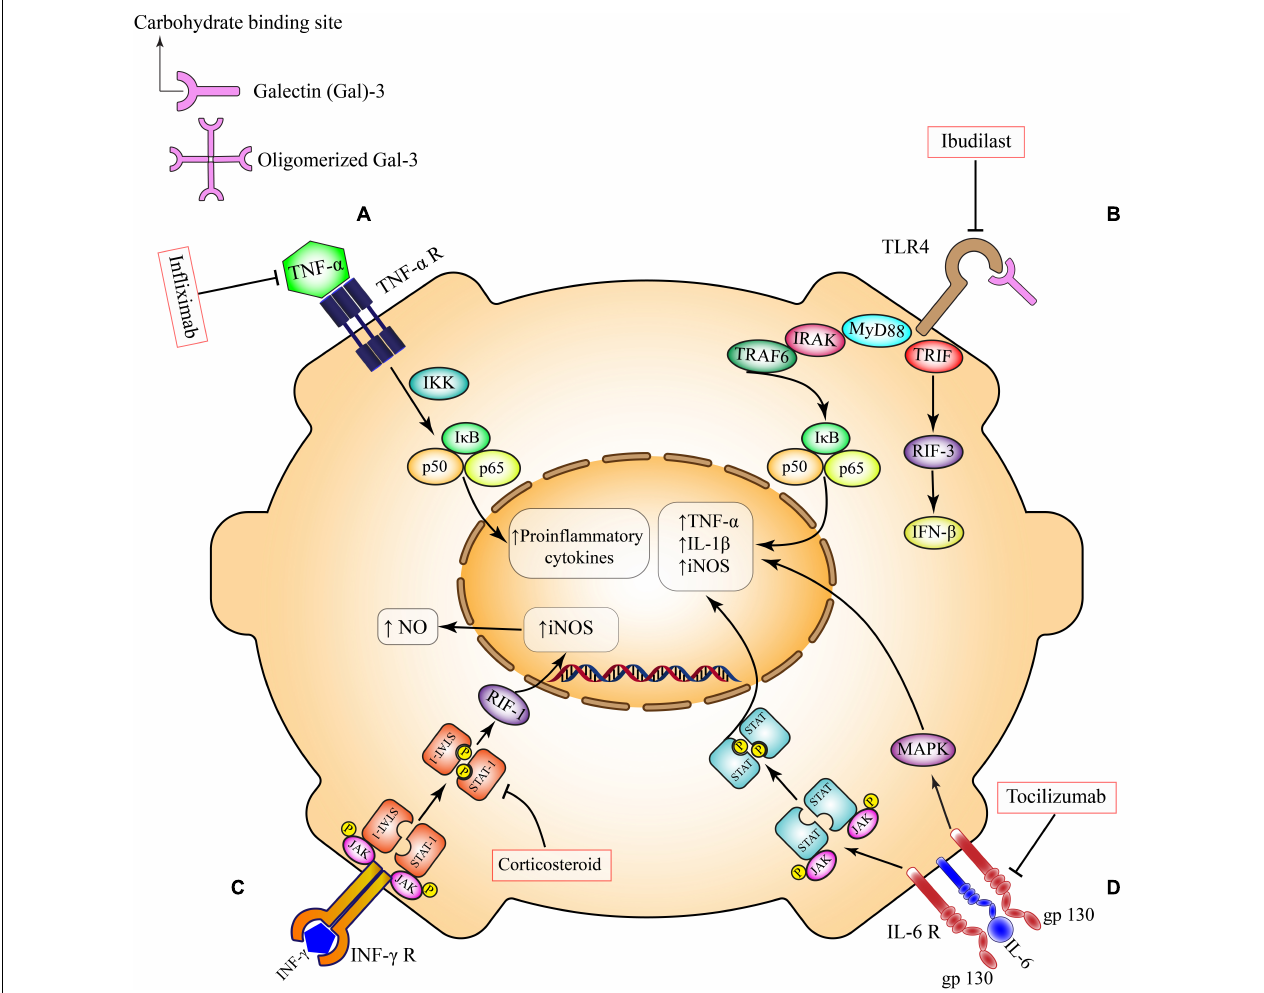
FIGURE 1 | Pro-inflammatory pathways in microglia. (A) TNF- α receptor activation, induces the canonical pro-inflammatory transcriptional factors such as NF κ B and subsequent production of inflammatory mediators. This pathway can be inhibited by Infliximab. (B) TLR4 ligands and secreted Gal-3 directly bind to TLR4 on the microglial surface and exacerbates inflammatory responses through induction of different cytokines and chemokines. This pathway can be inhibited by Ibudilast. (C) Activation of INF- γ receptor on microglia triggers the overexpression of inducible nitric oxide synthase (iNOS) and overproduction of nitric oxide via Janus kinase (JAK)/signal transducer and activator of transcription (STAT)/RIF-1 pathway. Corticosteroids can suppress this pathway at the level of STAT factors. (D) IL-6 trans -signaling occurs in brain cell types that have membrane bound gp130, including microglia. IL-6 bound to soluble IL-6R activates signaling through membrane bound gp130. This trans -signaling is thought to be pro-inflammatory via the induction of JAK/STAT and MAPK signaling pathways. Tocilizumab inhibits this pro-inflammatory pathway. TNF- α , tumor necrosis factor- α ; IKK, the I κ B kinase; NO, nitric oxide; iNOS, inducible nitric oxide synthase; IL-1 β , interleukin 1 beta; IL-6, interleukin 6; JAK, Janus kinase; STAT, signal transducer and activator of transcription; RIF-1, replication timing regulatory factor 1; MAPK, a mitogen-activated protein kinase; TLR4, toll-like receptor 4; MYD88, myeloid differentiation primary response 88; TRIF, TIR-domain-containing adapter-inducing interferon- β ; IRAK, interleukin 1 receptor associated kinase; TRAF, TNF receptor associated factor; IFN- β , interferon- β ; IFN- γ , interferon